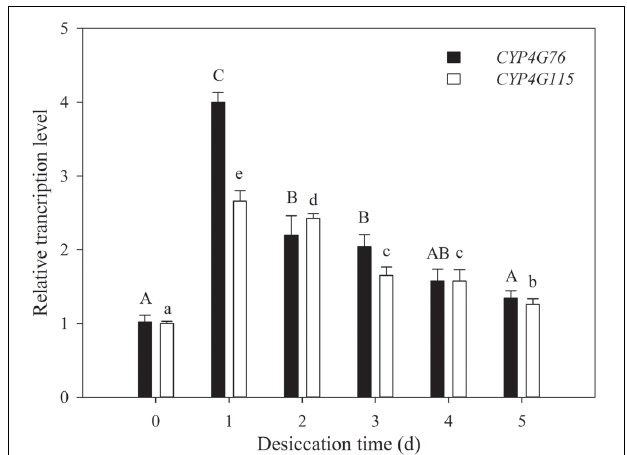
FIGURE 2 | Response of CYP4G76 and CYP4G115 transcription levels of third instar Nilaparvata lugens nymph to desiccation conditions (RH < 5% for 1–5 days). The control group was at 70% RH. Mean ± SE was calculated from five biological replicates, and each biological replicate contained ten N. lugens nymphs. Capital letters indicate significant differences between instar stages of CYP4G76 , and lowercase letters indicate significant differences in instar stages of CYP4G115 (ANOVA, LSD, p < 0.05).